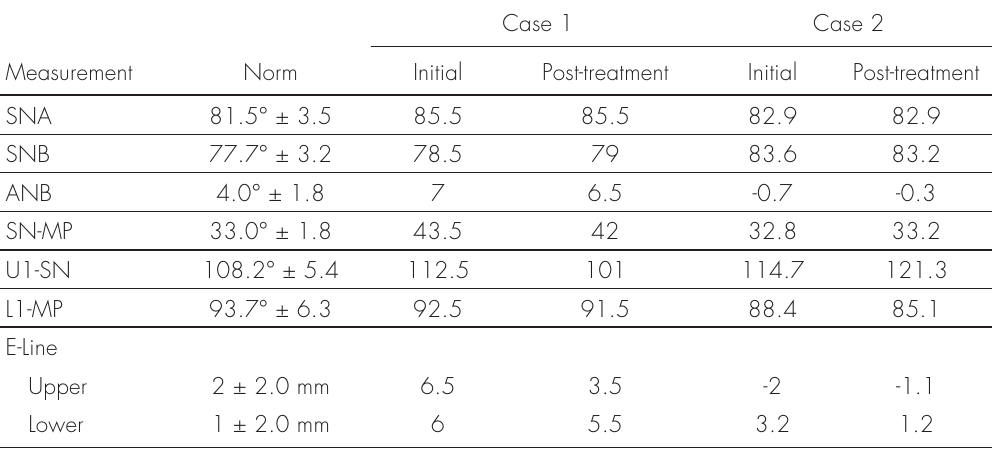
Table I. Pre-treatment and post-treatment cephalometric